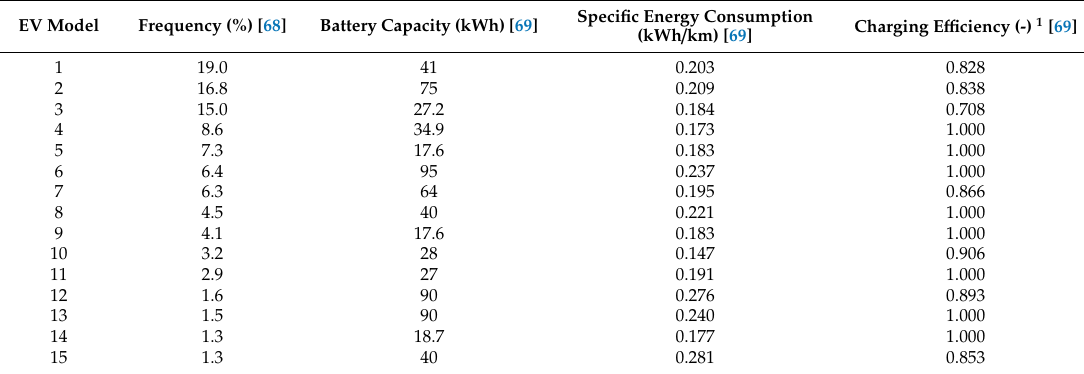
Table A5. Specifics of EV models applied for modeling EV charging